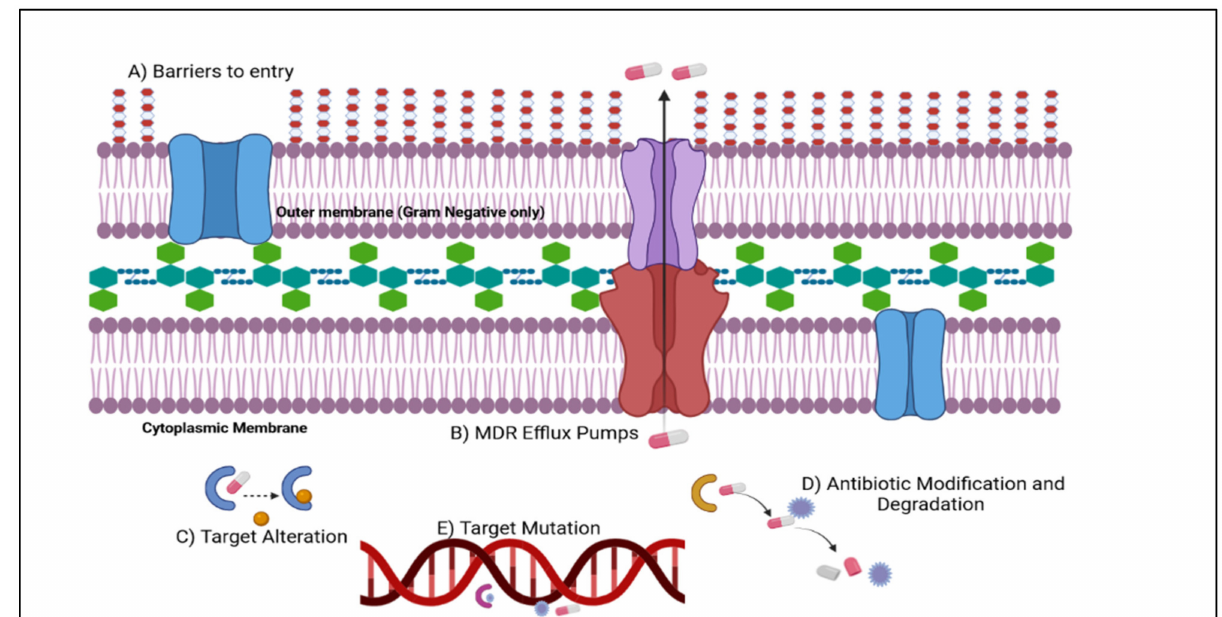
Figure 3. Intrinsic and acquired antibiotic resistance in bacteria. ( A ) Barriers to entry include the outer membrane of Gram-negative bacteria and associated protein pores; ( B ) efflux pumps; ( C ) target alteration; ( D ) antibiotic modification and degradation; ( E ) antibiotic target